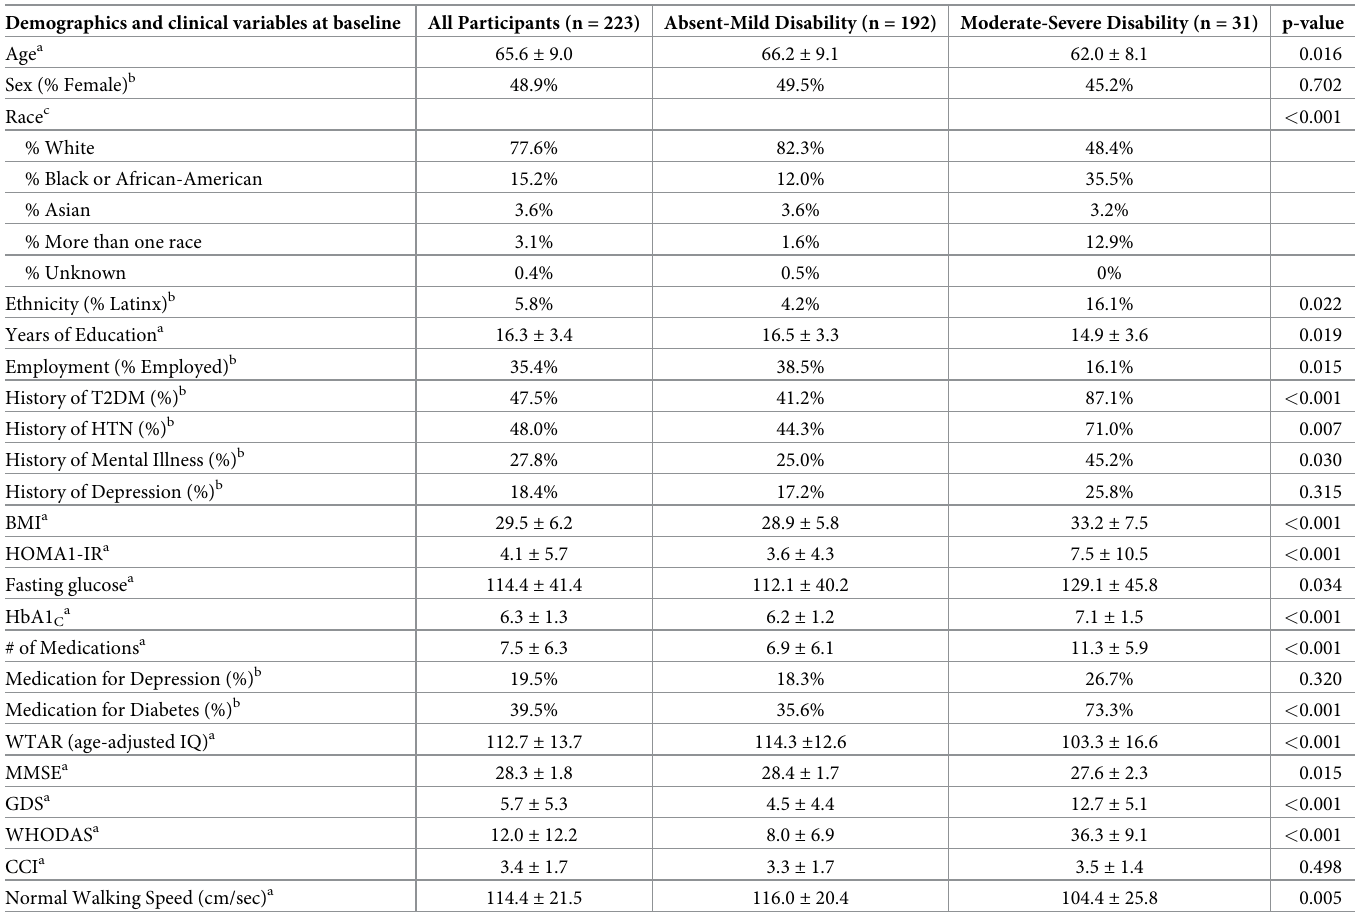
Table 1. Demographics and clinical variables. Demographics and clinical variables at